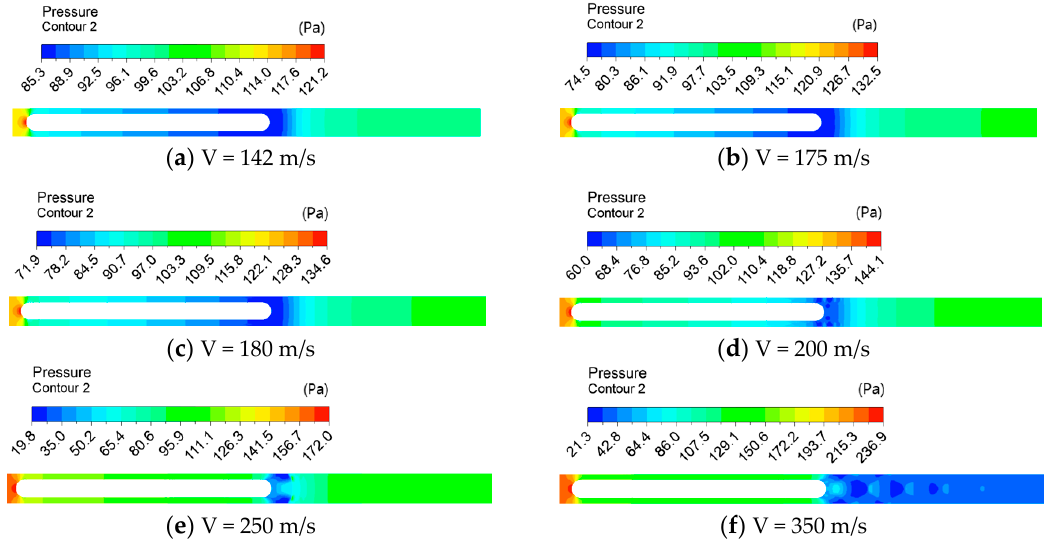
Figure 8. Pressure contours around pod for various pod speeds.